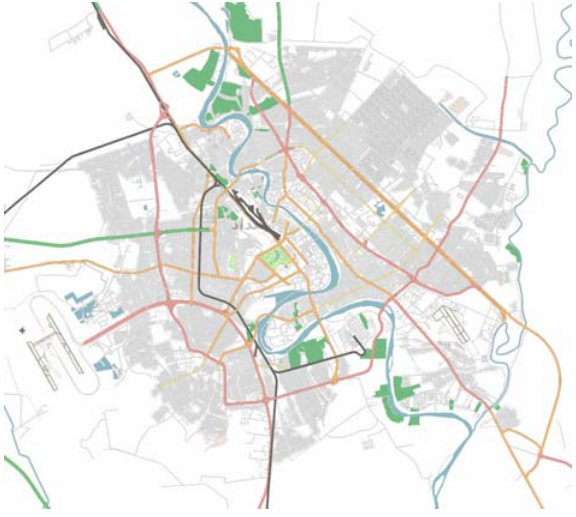
Figure 8: Baghdad City, using OSM, mapped remotely by volunteers, from imagery, with ground checks.